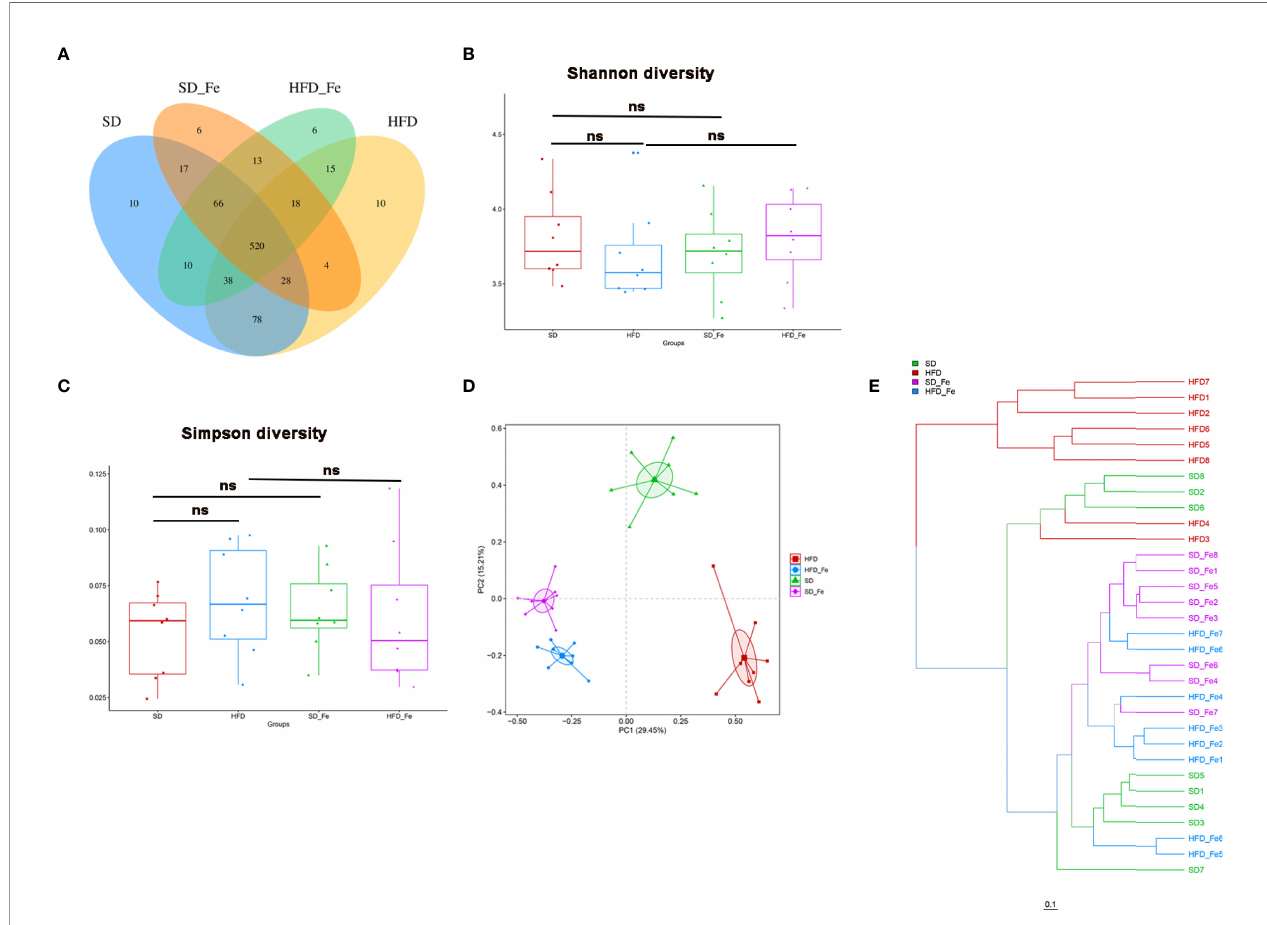
FIGURE 5 | Feno fi brate altered overall structure of gut microbiota of high-fat diet (HFD)-fed mice. (A) Venn diagram showing the unique and shared OTUs in the different groups. (B – C) Community diversity of gut microbiota in mice; (B) Shannon diversity, (C) Simpson diversity. (D) Principal component analysis (PCA) analysis of gut microbiota in mice. (E) Hierarchical clustering (weight unifrac distance) of microbiota of the four groups. SD group, standard diet group; HFD group, high-fat diet group; SD_ Fe group, standard diet plus feno fi brate group; HFD_ Fe group, high-fat diet plus feno fi b rate group. n = 8; ns, not signi fi